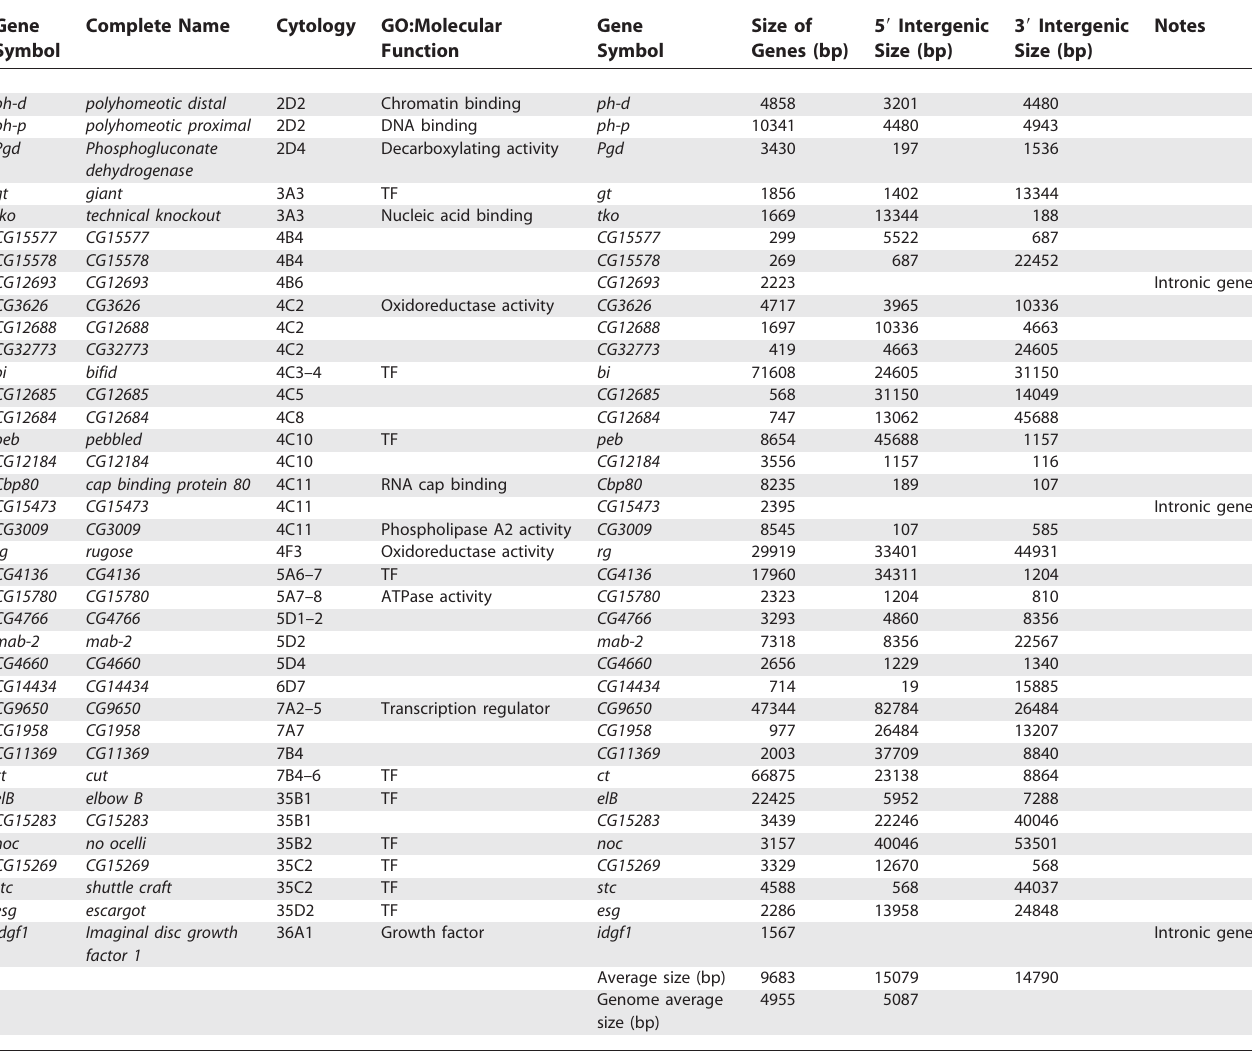
Table 1. List of Target Genes for PRC1 at the Embryonic